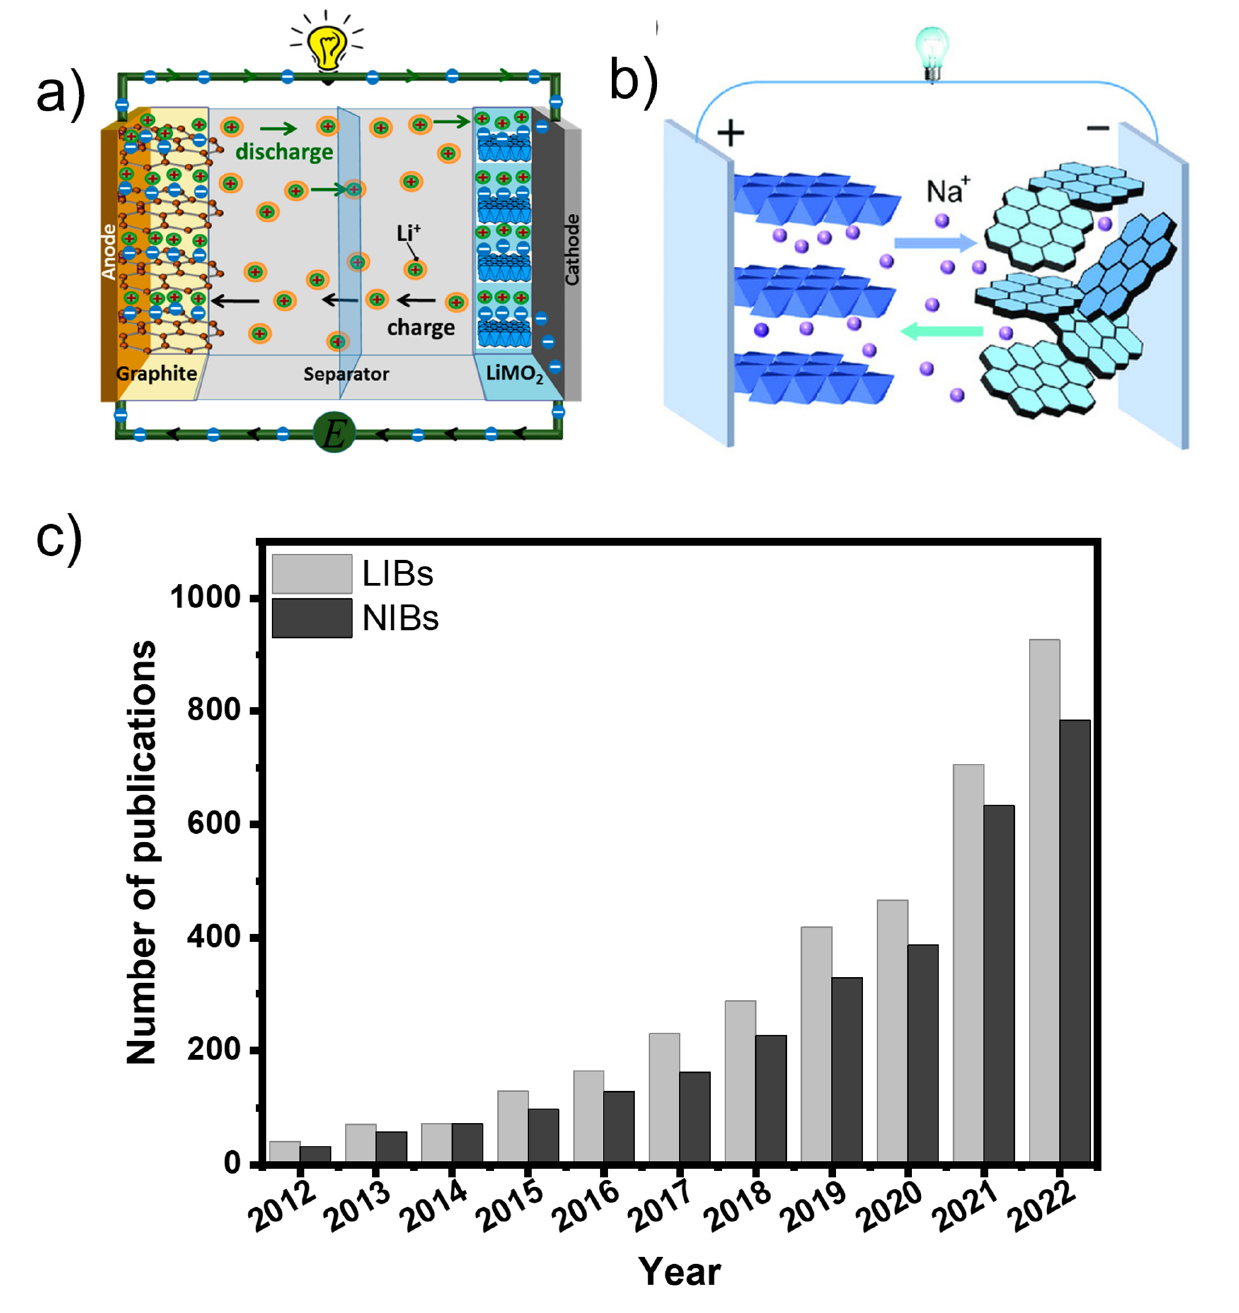
Figure 1. ( a , b ) A schematic and working principle of LIBs (Reproduced from [9] with permission from MDPI) and NIBs (Reproduced from [10] with permission from Wiley). ( c ) The number of published articles from 2012 to 2022 for “biomass anodes for lithium-ion battery” and “biomass anodes for sodium-ion battery” (Web Source: Science Direct).